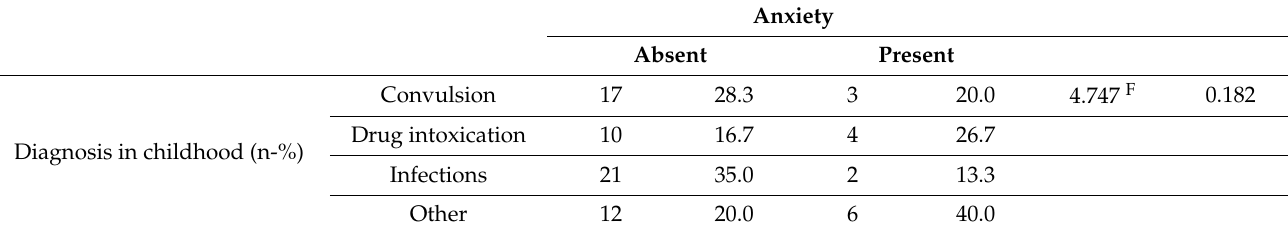
Table 4. Comparison of the characteristics of the participants regarding the presence of